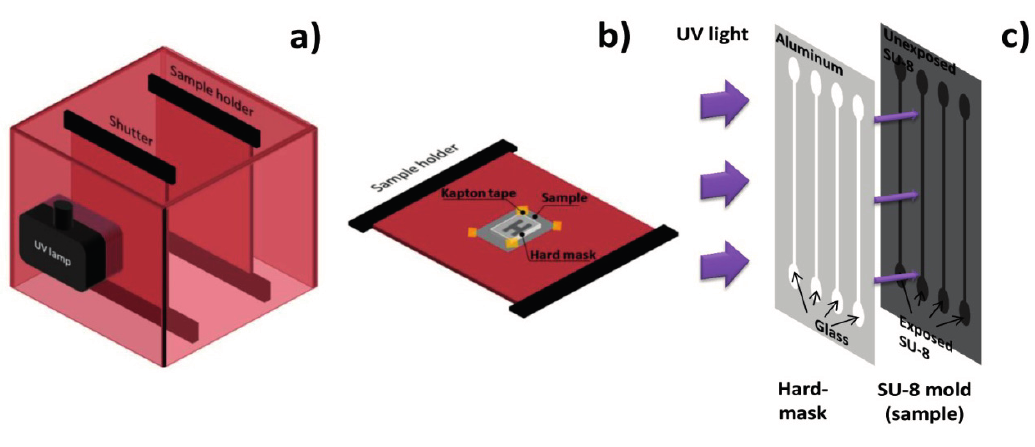
Figure 6. Schematics of the contact microlithography steps: ( a ) UV exposure setup; ( b ) Sample holder with hard-mask assembled over SU-8 substrate; ( c ) SU-8 negative resist exposure process.